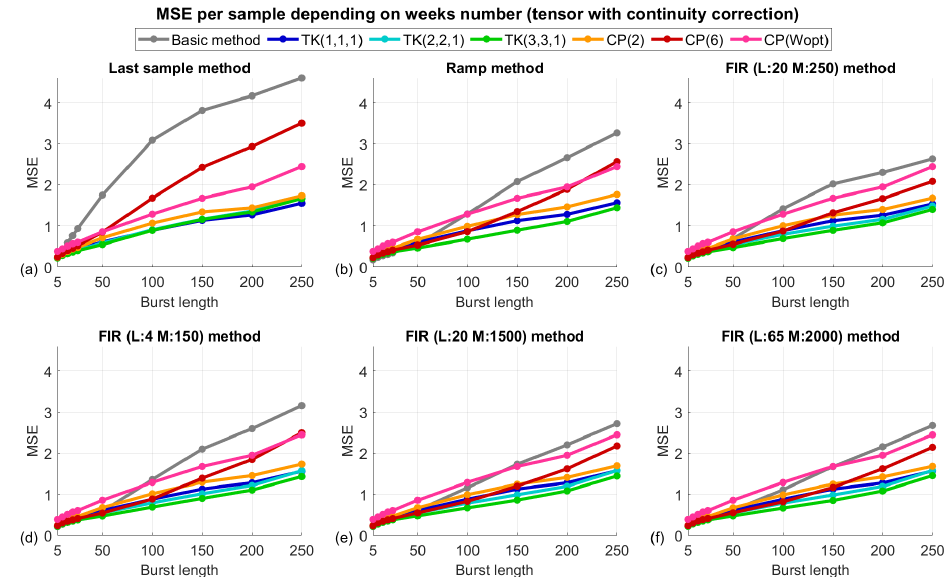
Figure 14. Trend of the MSE with a progressively increasing number of samples. The results are the mean of 1000 simulations. The tensor contains three weeks worth of data (288,7,3), and the position of the first missing sample of the burst is randomly